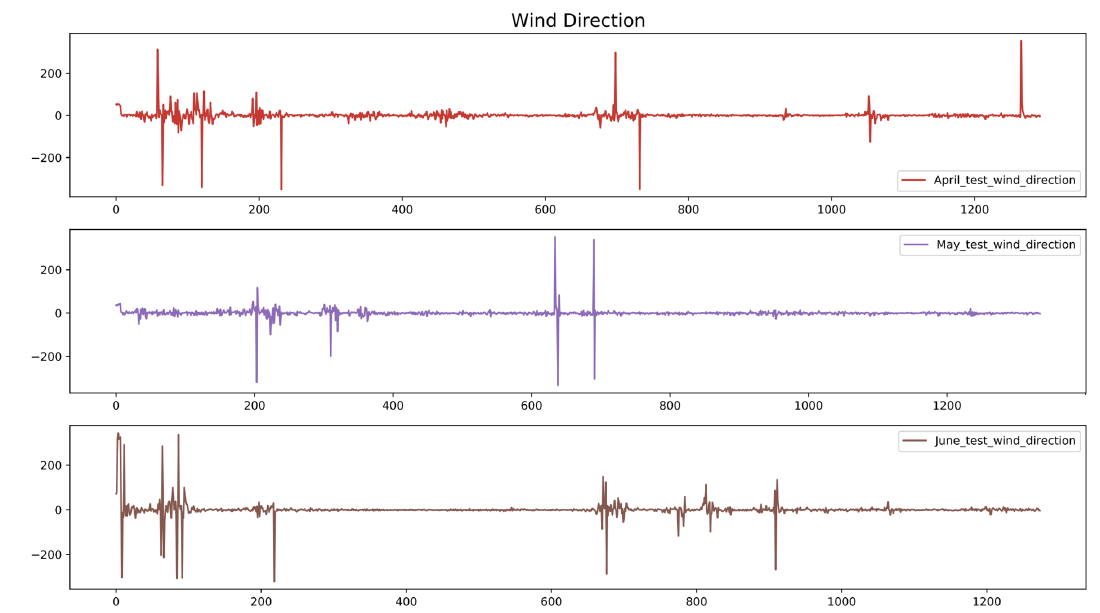
Figure 17. The difference between the actual and predicted value of wind direction over the test set of April, May, and